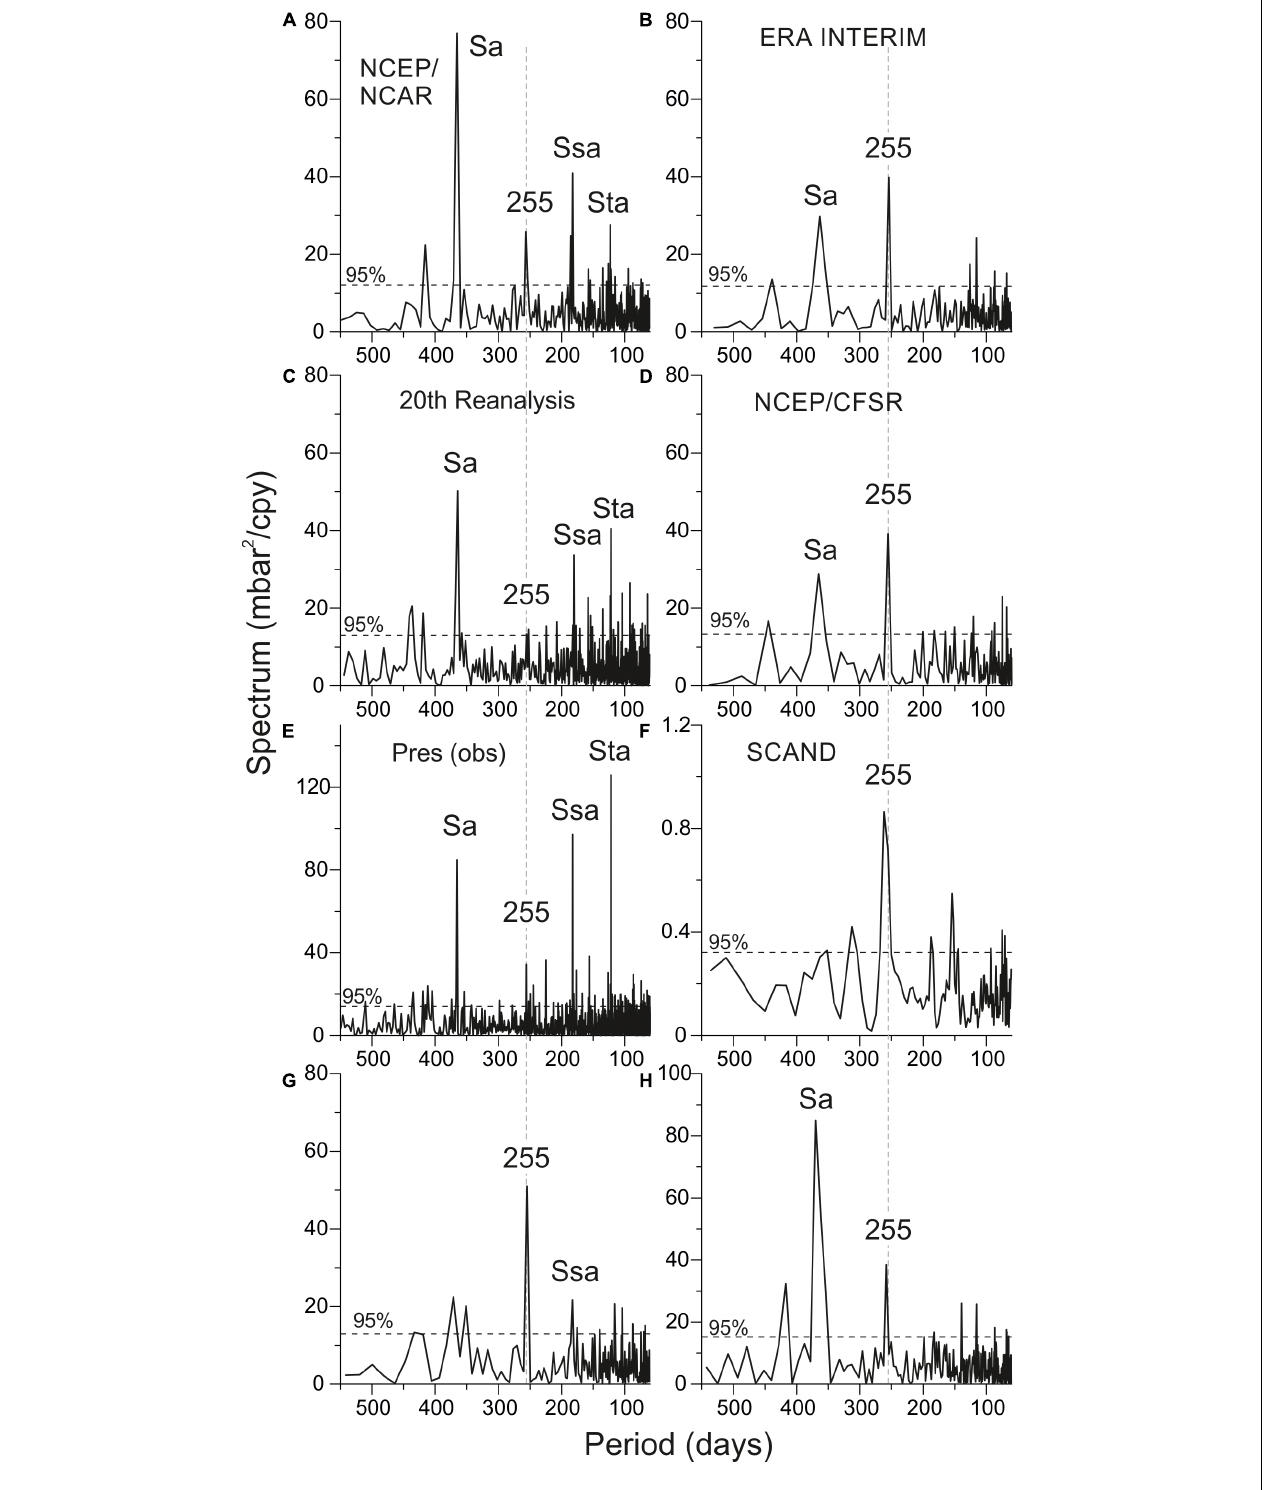
FIGURE 7 | The air pressure spectra estimated from (A) NCEP/NCAR, (B) ERA-Interim, (C) 20th Century Reanalysis, (D) NCEP/CFSR reanalysis, air pressure observations at (E) Stockholm, (G) Pirkkala Tampere-Pirkkalan Lentoasema, (H) Pello Kk Museotie weather stations, and (F) Scandinavian index time series. Labels “Sa,” “Ssa,” “Sta,” and “255” mark annual, semiannual, terannual, and 255-daily spectral peaks, respectively. Thin dashed lines show 95% significance level calculated according to Chi-squared distribution.